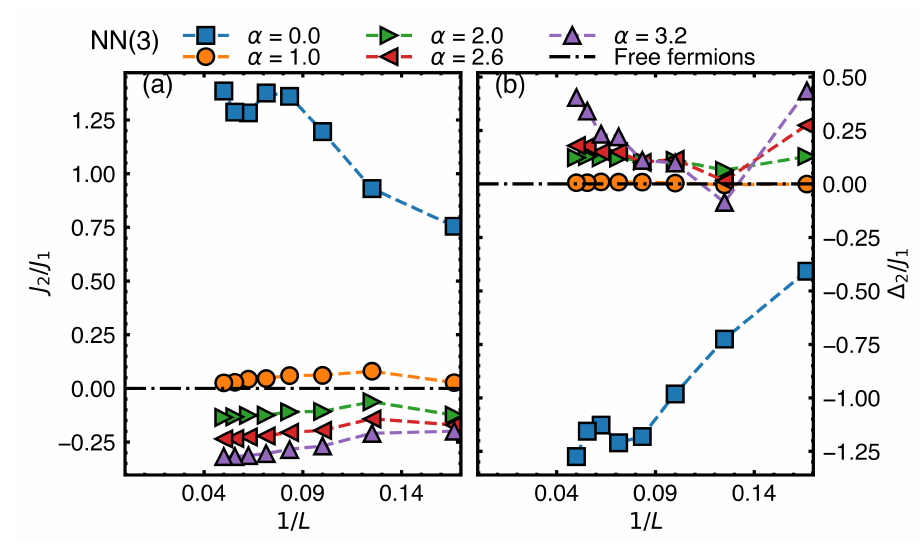
/ J / J and J versus inverse system 2 1 2 1